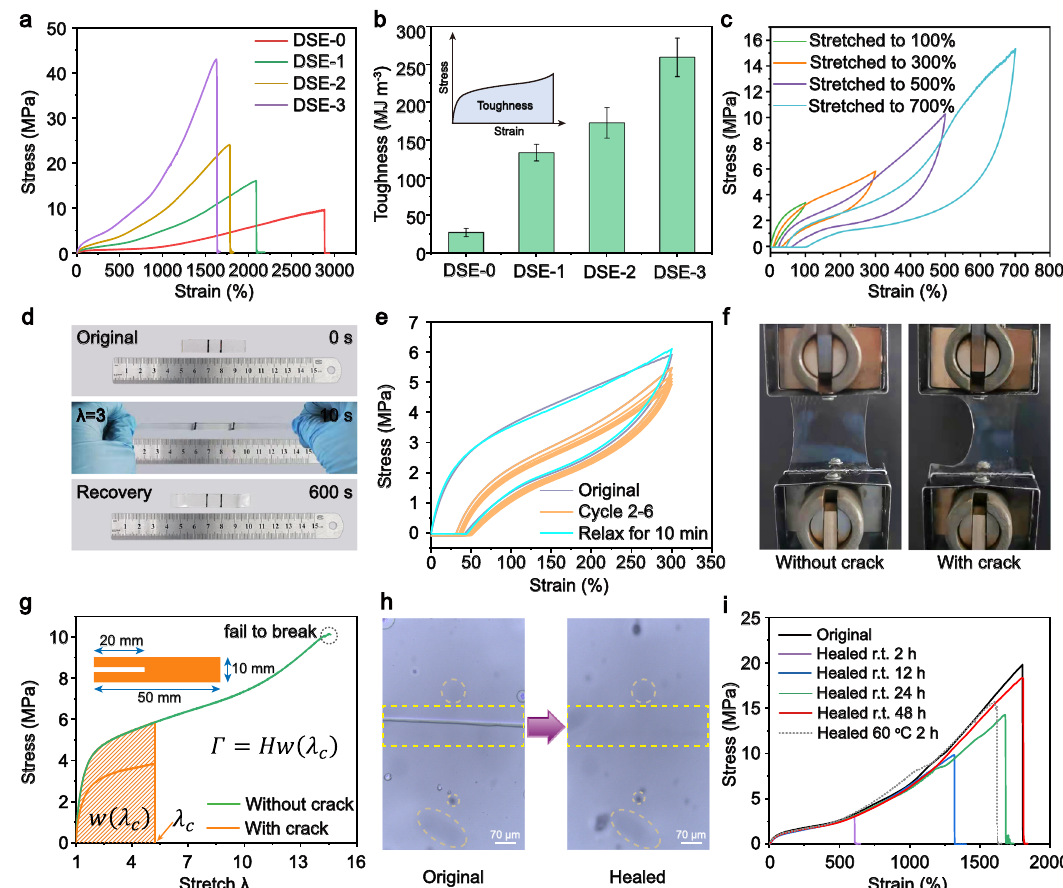
Fig.3|Mechanicalpropertiesandself-healingcapabilityofDSE.a Typicalstress- straincurvesofDSE-0~3.Maximumstrainandstressreach1630.53%and42.60MPa for DSE-3 with a 30% UPy motif, respectively. b Toughness of DSE-0~3. It is calcu- lated by the integrate area of the stress-strain curves. Error bars represent the standard deviation calculated by the data sets ( n =3). c Successive cyclic tensile behavior of DSE-3 at different strains (100%, 300%, 500%, 700%). The larger the tensile strain, the more pronounced the hysteresis loop, which indicated that DSE caneffectivelydissipatedstrainenergy(akeyfeatureforhightoughness)causedby the breaking ofdynamicbondsduringstretching – retractioncycles atthe different strains. d Digital images for DSE-3 fi lm that can restore to its original length after